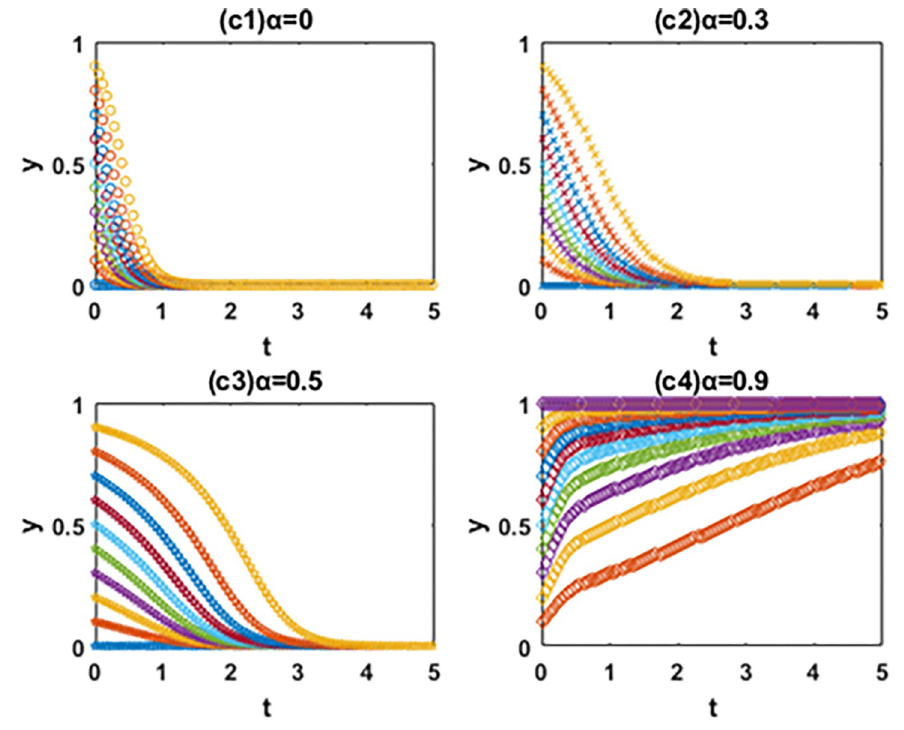
Fig 8. Effects of α on the path selection of the follower enterprise